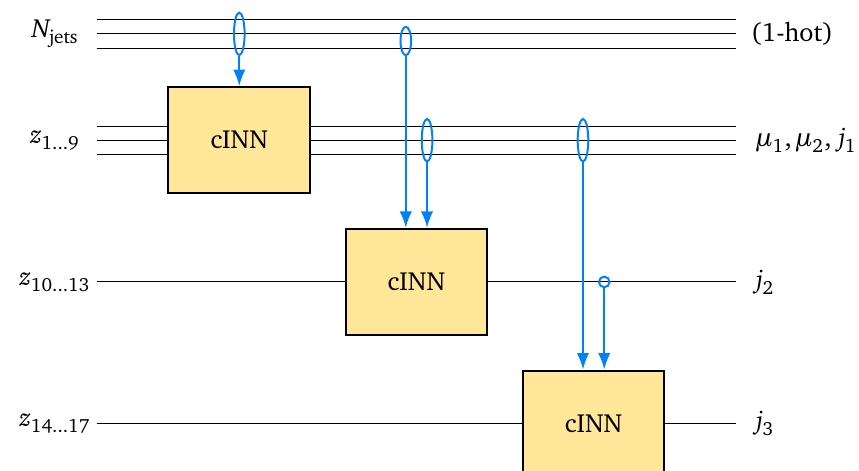
Figure 1: Generative flow architecture for events with two muons and one to three jets. The INNs relate the latent space (left) to the physical phase space (right).